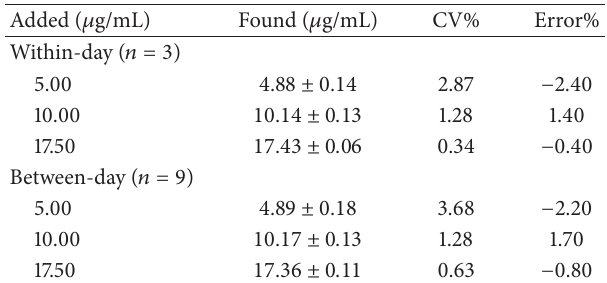
Table 3: Accuracy and precision data for determination of copper in one day ( 𝑛 = 3 ) and three subsequent days ( 𝑛 = 9